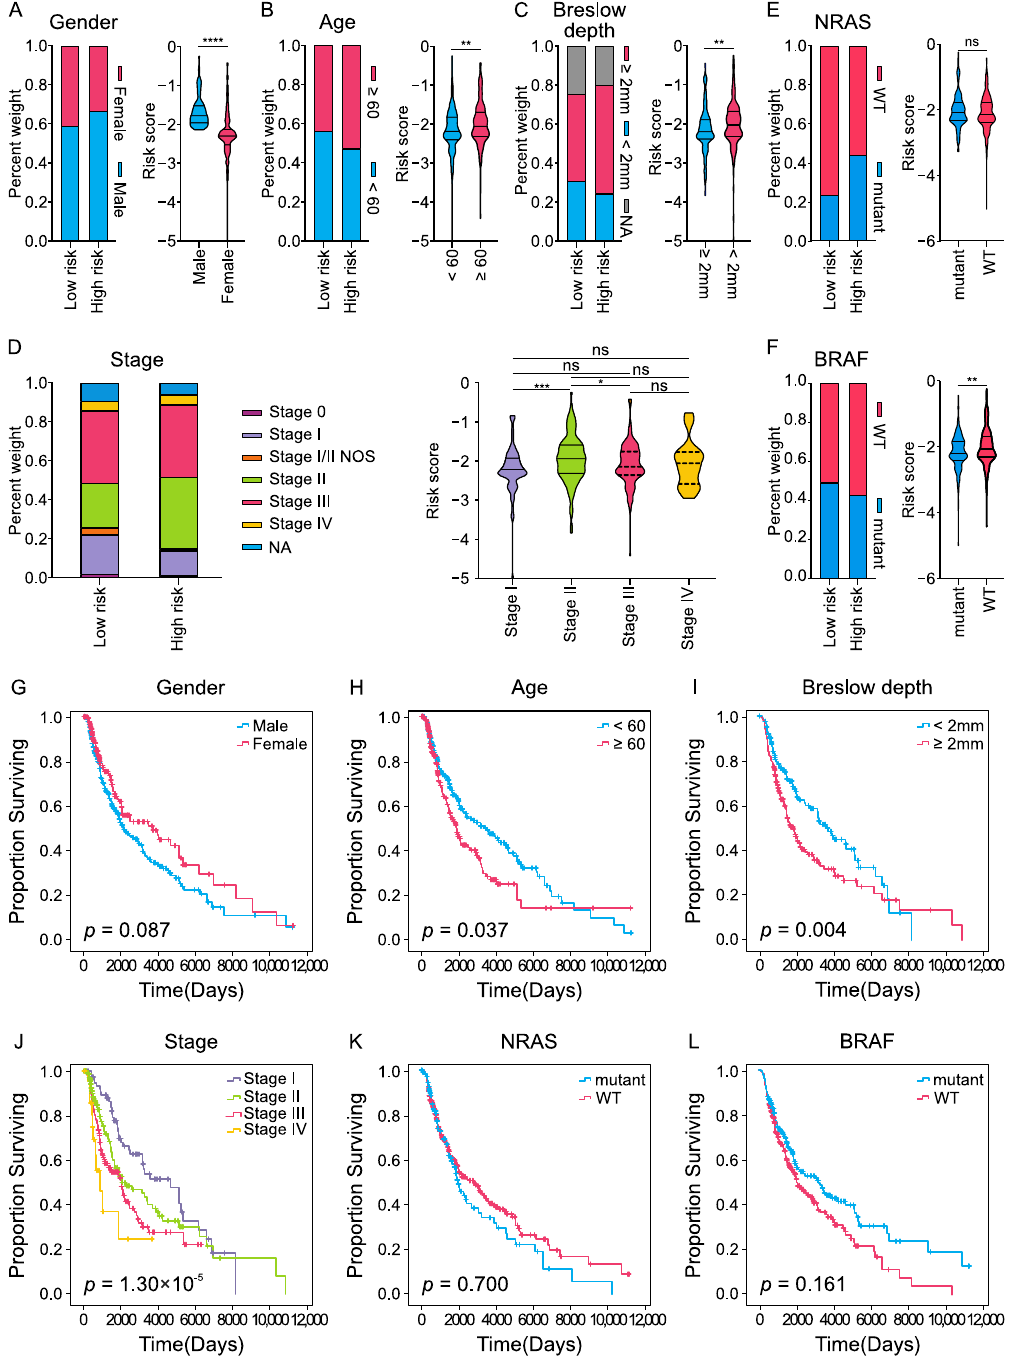
Figure 4. Association between the four-FRG DNA methylation signature and clinical characteristics in the TCGA cohort: ( A – F ) Proportion of clinical characteristics (age, gender, stage, and Breslow depth) in the low- or high-risk group, and the distribution of risk scores in different groups based on clinical characteristics. *** p < 0.0001, *** p < 0.001, ** p < 0.01, * p < 0.05, ns means no significance. ( G – L ) Kaplan–Meier analysis of CM patients stratified by clinical characteristics.